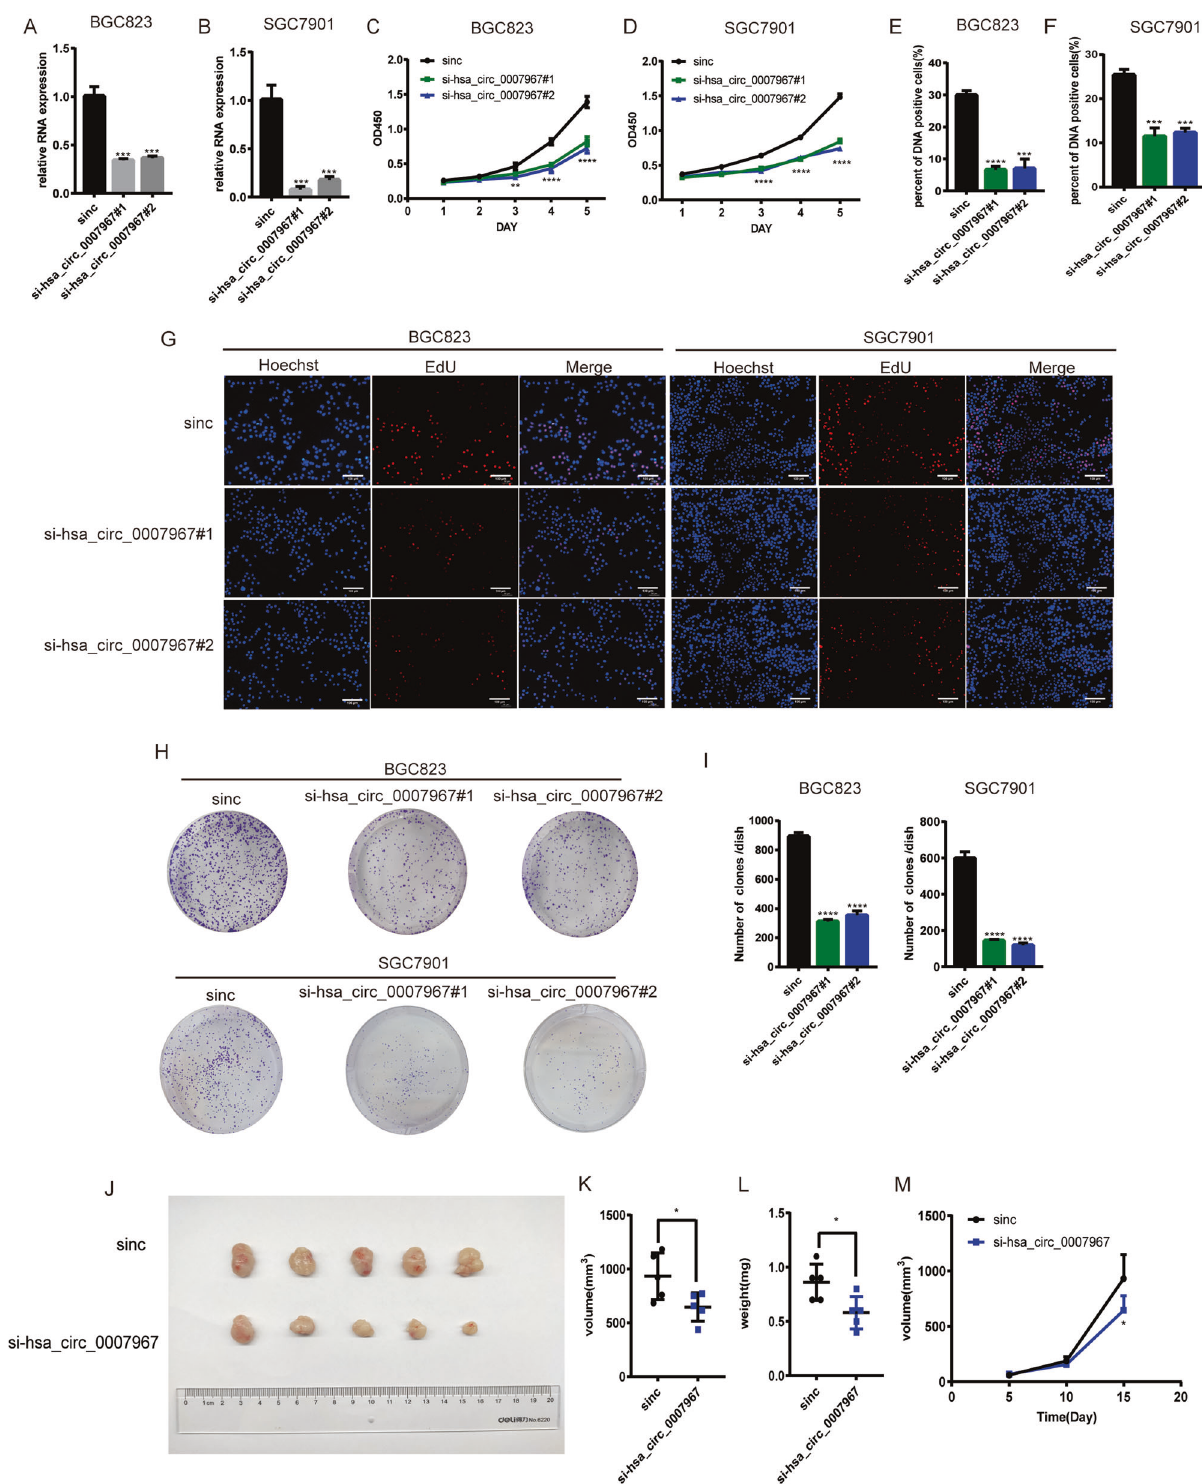
Fig. 3 Silencing hsa_circ_0007967 inhibits GC proliferation in vitro and in vivo. A , B The expression of hsa_circ_0007967 in BGC823 and SGC7901 cells transfected with sinc, si-hsa_circ_0007967#1, and si-hsa_circ_0007967#2. C , D The growth rate of BGC823 and SGC7901 cells transfected with sinc, si-hsa_circ-0007967#1, and si-hsa_circ-0007967#2 by cck8 assays. E , F DNA positive cells of BGC823 and SGC7901 cells transfected with sinc, si-hsa_circ-0007967#1, and si-hsa_circ-0007967#2 by EdU assays. G EdU assays of BGC823 and SGC7901 cells transfected with sinc, si-hsa_circ-0007967#1, and si-hsa_circ-0007967#2. H , I The assessment of proliferation of BGC823 and SGC7901 cells transfected with sinc, si-hsa_circ_0007967#1, and si-hsa_circ_0007967#2 by colony formation assays. J – L Tumors from mice in two different groups, and the weight and volume of tumors at the end point. M The weight of tumors measured every 5 days until the end point.